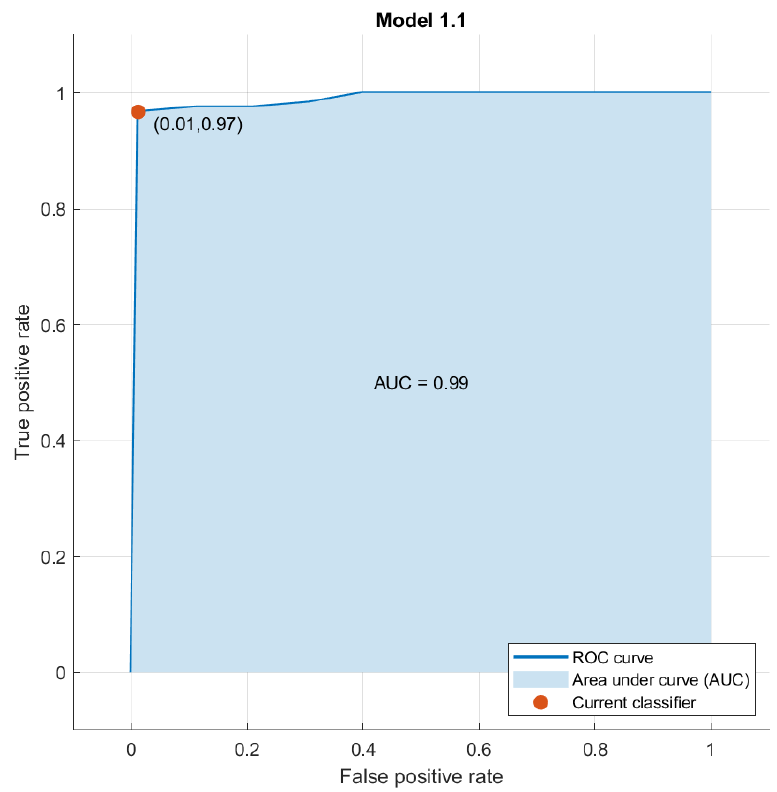
Figure 6. ROC curve for the model (1st group of data) .